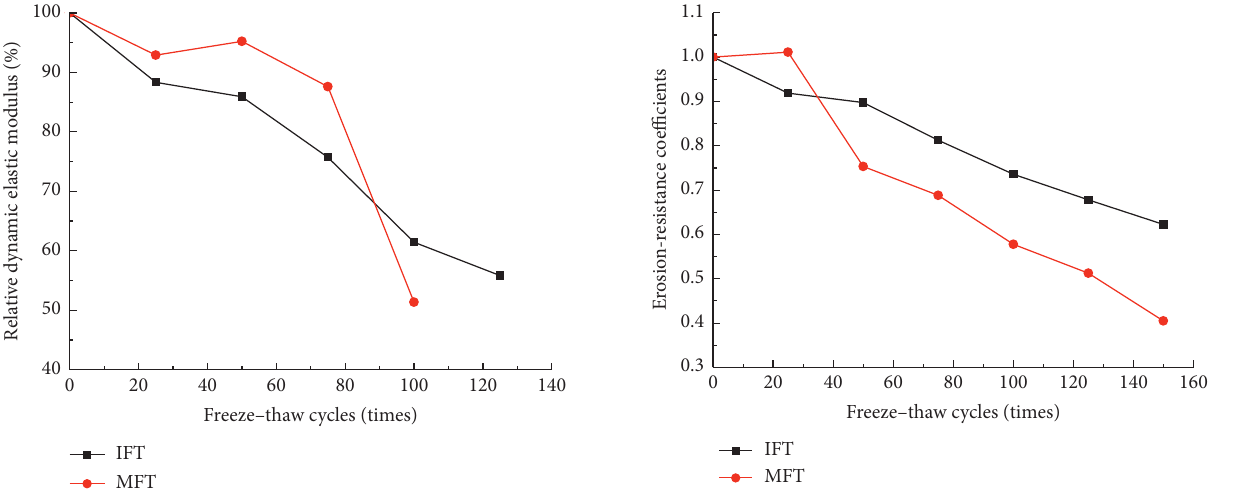
Figure 5: Variations of erosion-resistance coefficient of concrete specimens with freeze–thaw cycles in IFT and MFT